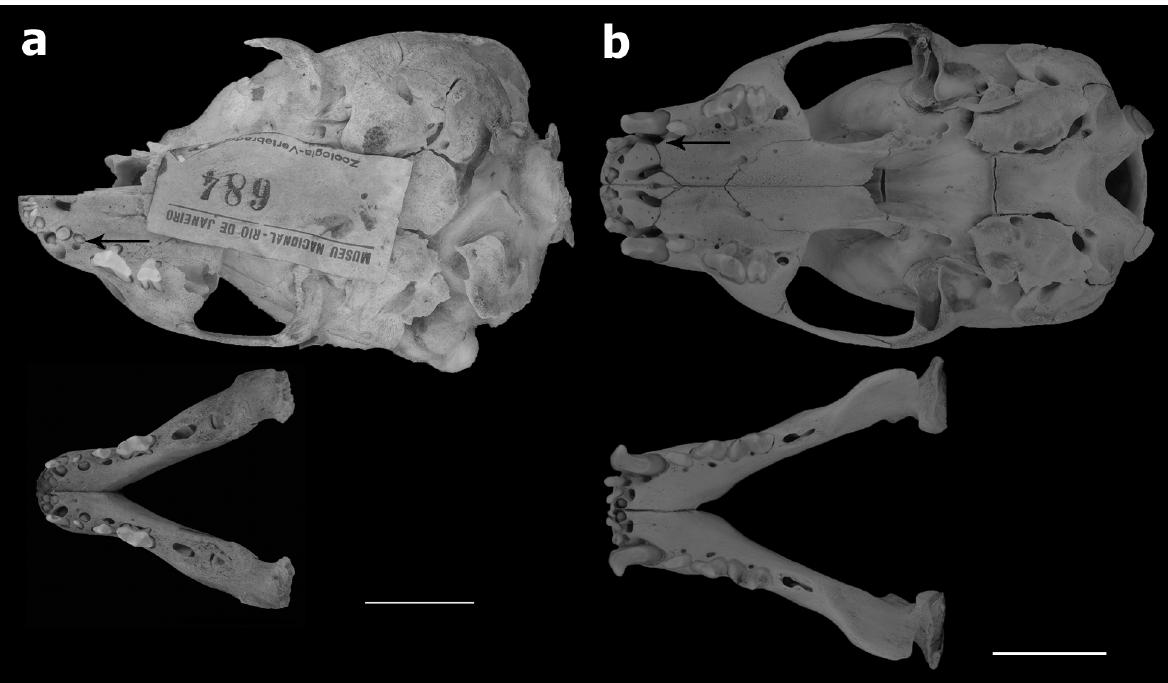
Figure 5. Occlusal view of the skull and mandible of juvenile specimens of a) Lontra longicaudis (MN684); b) Eira barbara (MN74385). Note the pits close to the base of each tooth (arrows), indicating replacement, except in P1 of L. longicaudis . Also note the carnassial and molar shapes of third and fourth premolars. The molar is about to erupt in these individuals. Scale bar =